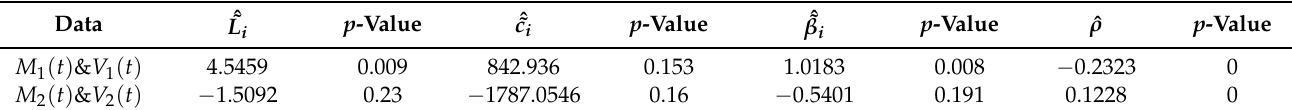
Table 7. Estimated drift group parameters (SLV and GLD).